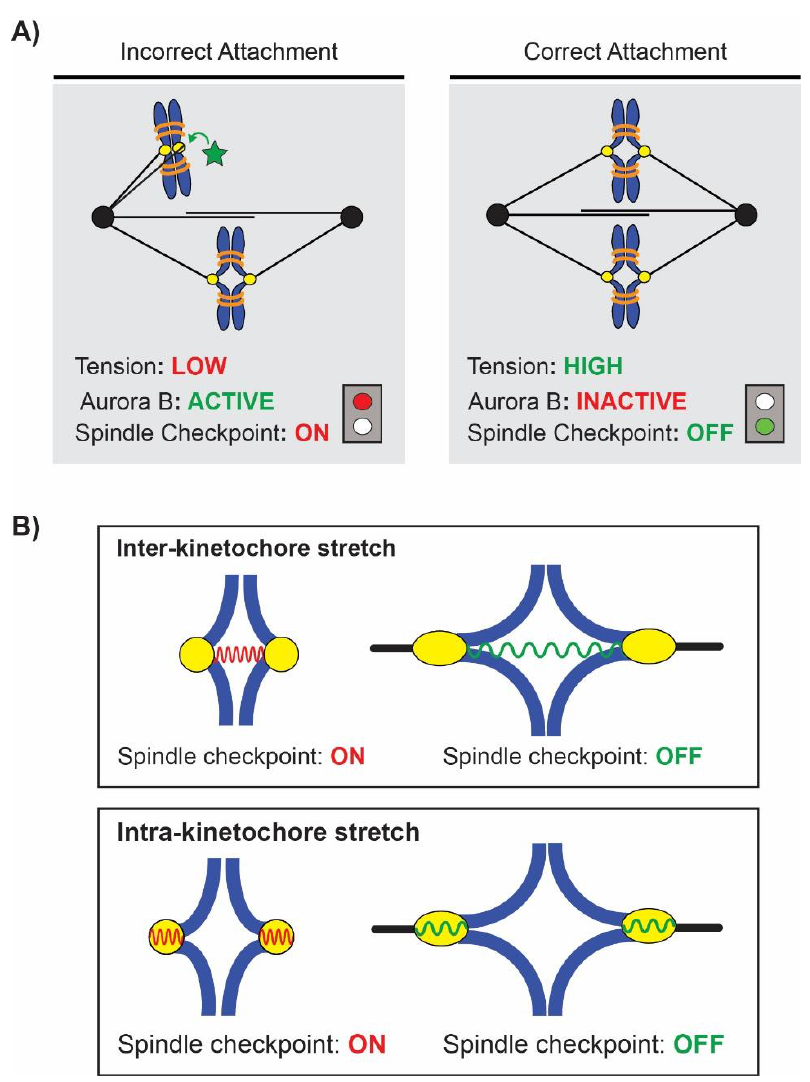
Figure 2. The spindle assembly checkpoint is activated by lack of or low tension on chromosomes. ( A ) Incorrect attachments have no or low tension, Aurora B kinase is active (green star) and the checkpoint is activated, halting cell cycle progression in metaphase until the error can be corrected. Correct attachment generates high tension, Aurora B kinase is inactive, and satisfies the checkpoint, silencing it and allowing the cell to proceed to anaphase. ( B ) Tension has been proposed to be measured either in the inter-kinetochore or intra-kinetochore region. Inter-kinetochore stretch is the distance between sister kinetochores and is facilitated via the stretching of spring-like elastic pericentric chromatin that inactivates the checkpoint. Intra-kinetochore stretch is the deformational distance produced within a kinetochore under tension and is facilitated via stretching and conformational change of kinetochore proteins.